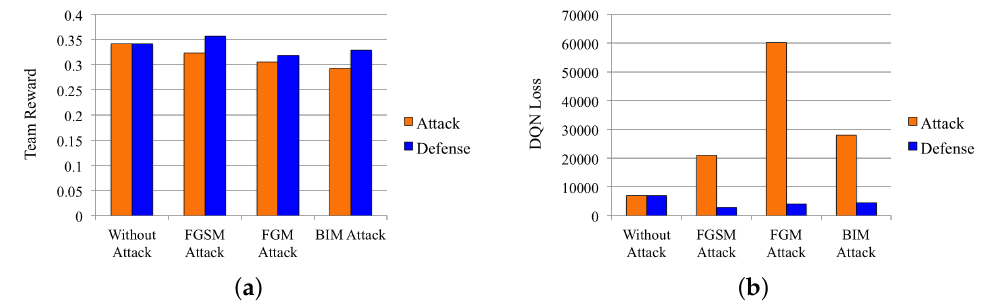
Figure 16. Team reward and DQN loss before and after using defense Algorithm 2 against various adversarial attacks, during 30,000 time steps. ( a ) Team reward before and after defense Algorithm 2. ( b ) DQN loss before and after defense Algorithm